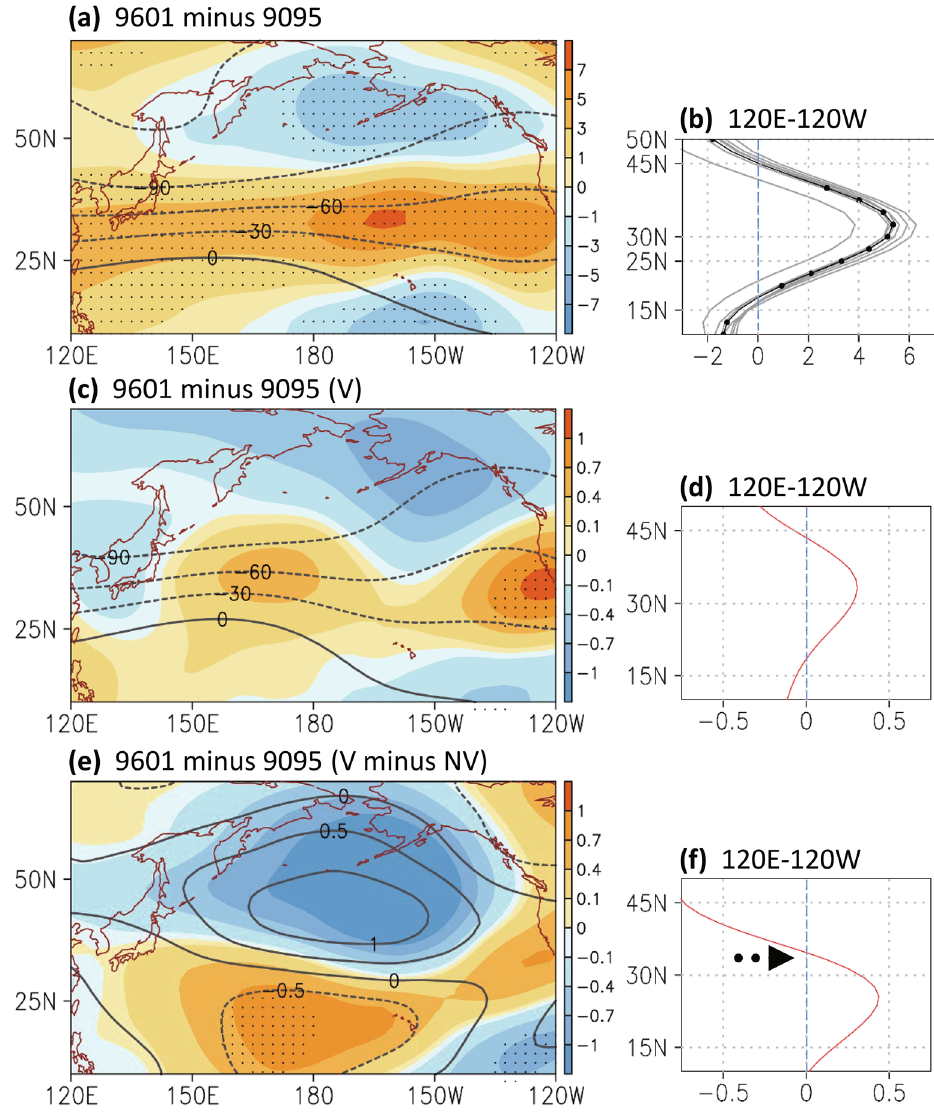
Figure 3. ( a ) The difference (1996–2001 minus 1990–1995) in the streamfunction at 300 hPa (unit: 10 6 m 2 s −1 ) of the reanalysis ensemble from December to February. Contour denotes the averaged streamfunction from 1990 to 1995. Dots over shading indicate that the difference in streamfunction had a confidence level of 90%. ( b ) Zonal mean (120° E–120° W) of the 300-hPa streamfunction difference in the seven-reanalysis data (gray; black line with dots for the ensemble mean-based result). ( c – d ) Same as ( a – b ) except for the decadal change in control simulation with volcanic forcing (V simulation). ( e – f ) Same as ( c – d ) except for the difference in the modeling decadal change (with minus without volcanic forcing); contour denotes the decadal change without including volcanic forcing (NV simulation). The Figure was generated using software Grid Analysis and Display System (GrADS) Version 2.1.1.b0 (http:// cola. gmu. edu/ grads/ grads.